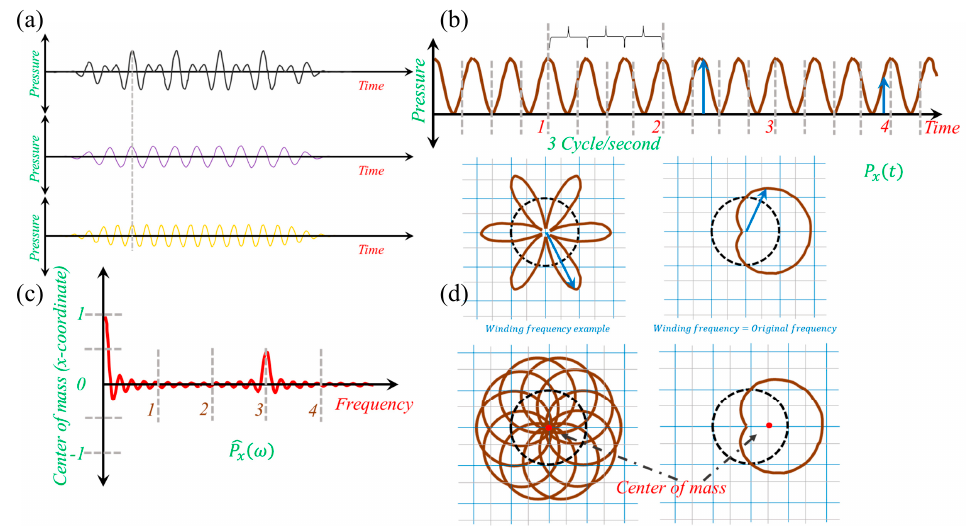
Figure 4. Illustration of the Fourier transformation, ( a ) frequency decomposition example, ( b ) original signal, ( c ) transformation from time to frequency domain, and ( d ) winding frequency example